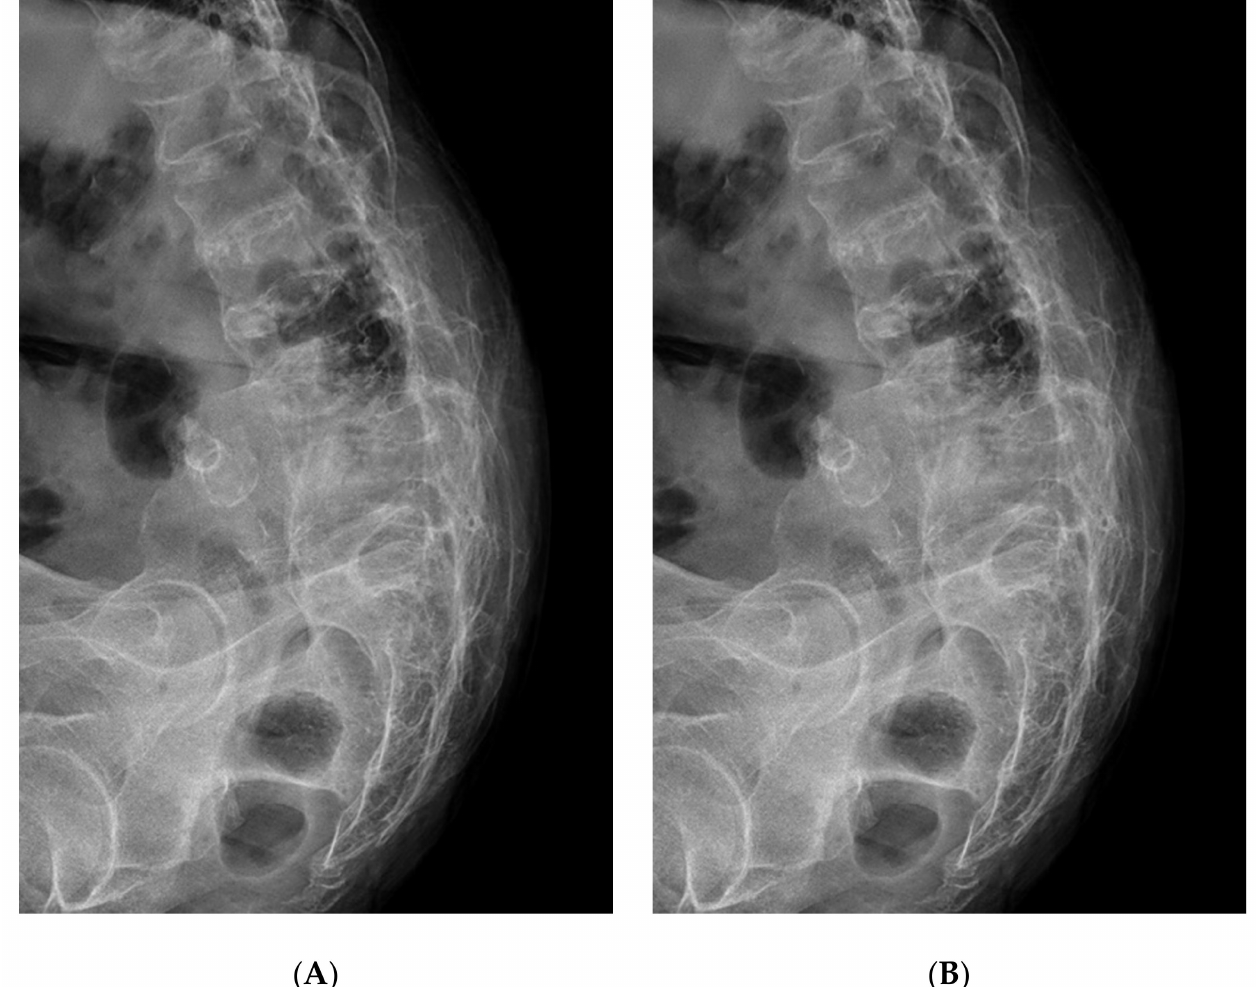
Figure 1. Flexion ( A )-extension ( B ) lateral plain radiograph prior to cord